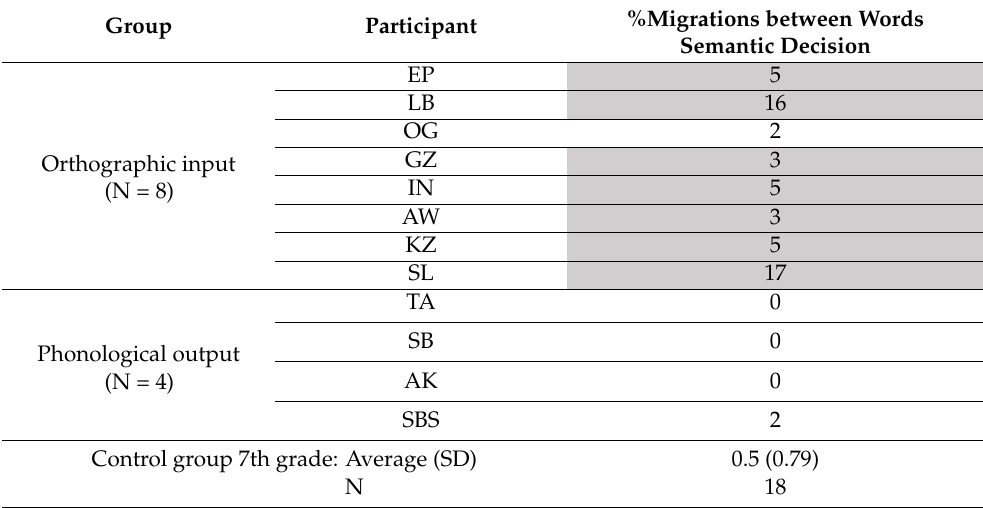
Table 4. The Watermelon semantic decision task: percentage of migrations between